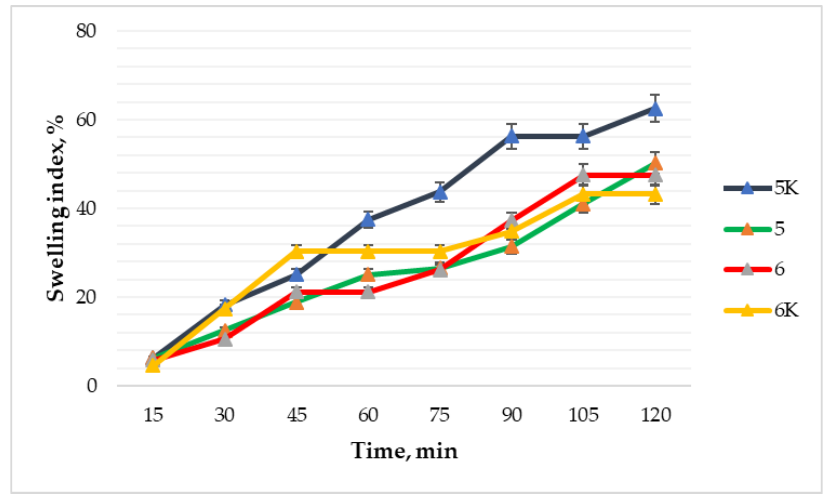
Figure 15. Comparison of swelling index, % variation with time (n = 3). The composition values are given in Table 1.